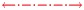
For 2016 epidemiology weeks (EW) 1–52, incidence rate (IR) per 100,000 population in 3 sites: Z-5, Z-7L and Z-14.In all 3 sites routine operational vector control activities were conducted, excluding wide area Bti spray treatment. However, in site Z-7L as from EW 27 until the end of the year (←⋅–⋅–⋅–⋅→) the wide area Bti spray application on fortnight intervals was integrated into the routine operational vector control activities.